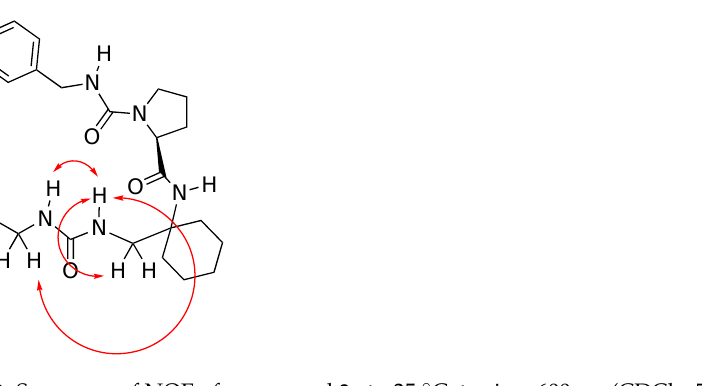
Figure 10. 2D NOESY spectrum of compound 3 at +25 °C, t-mix = 600 ms (CDCl 3 , 500 MHz). Sign of NOE peaks; red negative, blue positive.